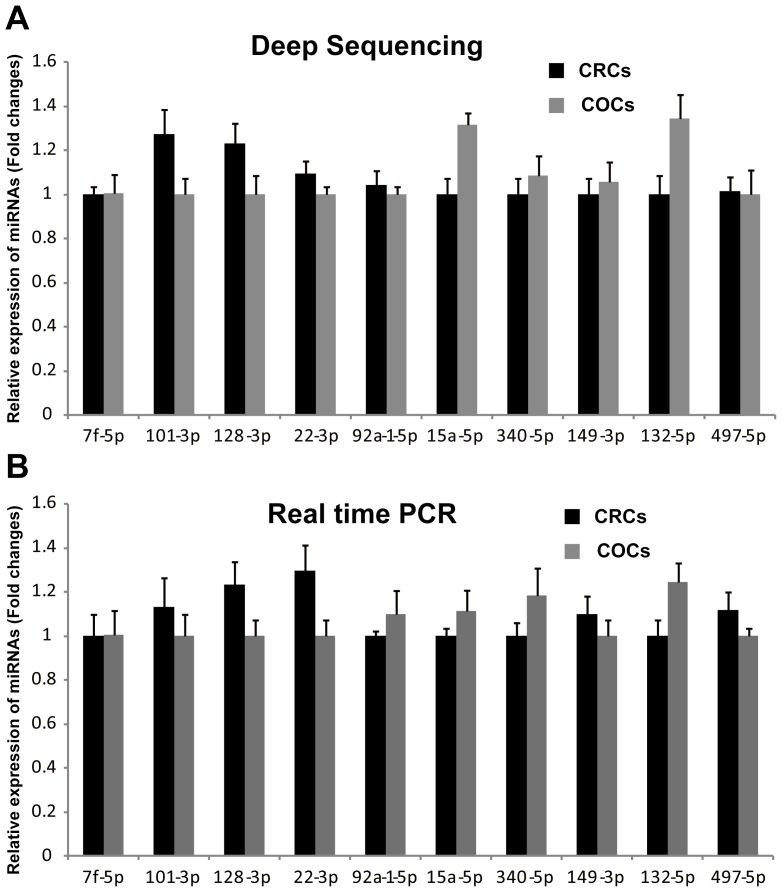
Confirmation of the expression of the most abundant miRNAs in both COCs and CRCs.Validation of the expression of ten miRNAs by NGS (A) and quantitative real-time PCR (B), demonstrating a similar expression pattern in COCs and CRCs.